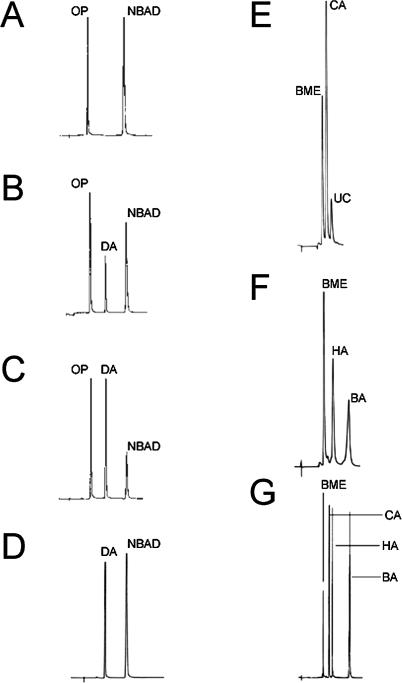
The CG12120 Gene Product Possesses NBAD Hydrolase and N-β-Alanyl Histamine (Carcinine) Hydrolase ActivitiesHPLC-ED chromatograms from activity assays.(A) Lysate from control (recombinant AGT) transfected Sf9 cells exhibited no activity. Oxidation product (OP) peak denotes uncharacterized presumptive oxidation product of NBAD present in NBAD substrate in all experiments.(B) NBAD incubated with CG12120 protein purified from Sf9 cells expressing CG12120 baculovirus construct after 20 min incubation with NBAD. Dopamine (DA) peak is evident.(C) Same experiment as in (B) but after 50 min incubation, showing increased accumulation of dopamine and depletion of NBAD.(D) Control HPLC chromatogram containing dopamine and NBAD standards.(E) Extract from control (recombinant AGT) transfected Sf9 cells exhibits no production of β-alanine and histamine when incubated with carcinine (CA). Unknown contaminant (UC) peak denotes an unknown contaminant in carcinine. β-mercaptoethanol (BME) peak denotes β-mercaptoethanol present in the reaction solution.(F) Extract from Sf9 cells transfected with CG12120 baculovirus incubated with carcinine demonstrates production of histamine (HA) and β-alanine (BA). Under the applied conditions, essentially all carcinine was hydrolyzed to histamine and β-alanine.(G) Control HPLC chromatogram containing β-mercaptoethanol, carcinine, histamine, and β-alanine standards. β-alanine and histamine detection were enabled by OPT conjugation (see Materials and Methods).